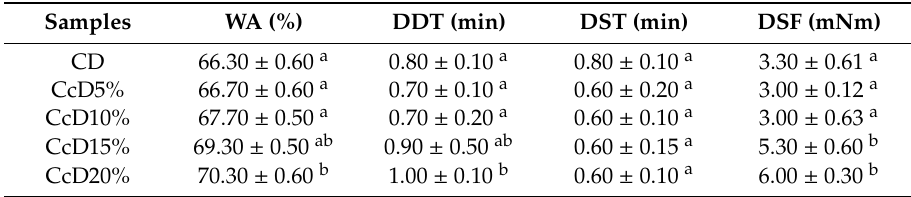
Table 2. Comparison of Microdoughlab mixing parameters: WA—water absorption (%),